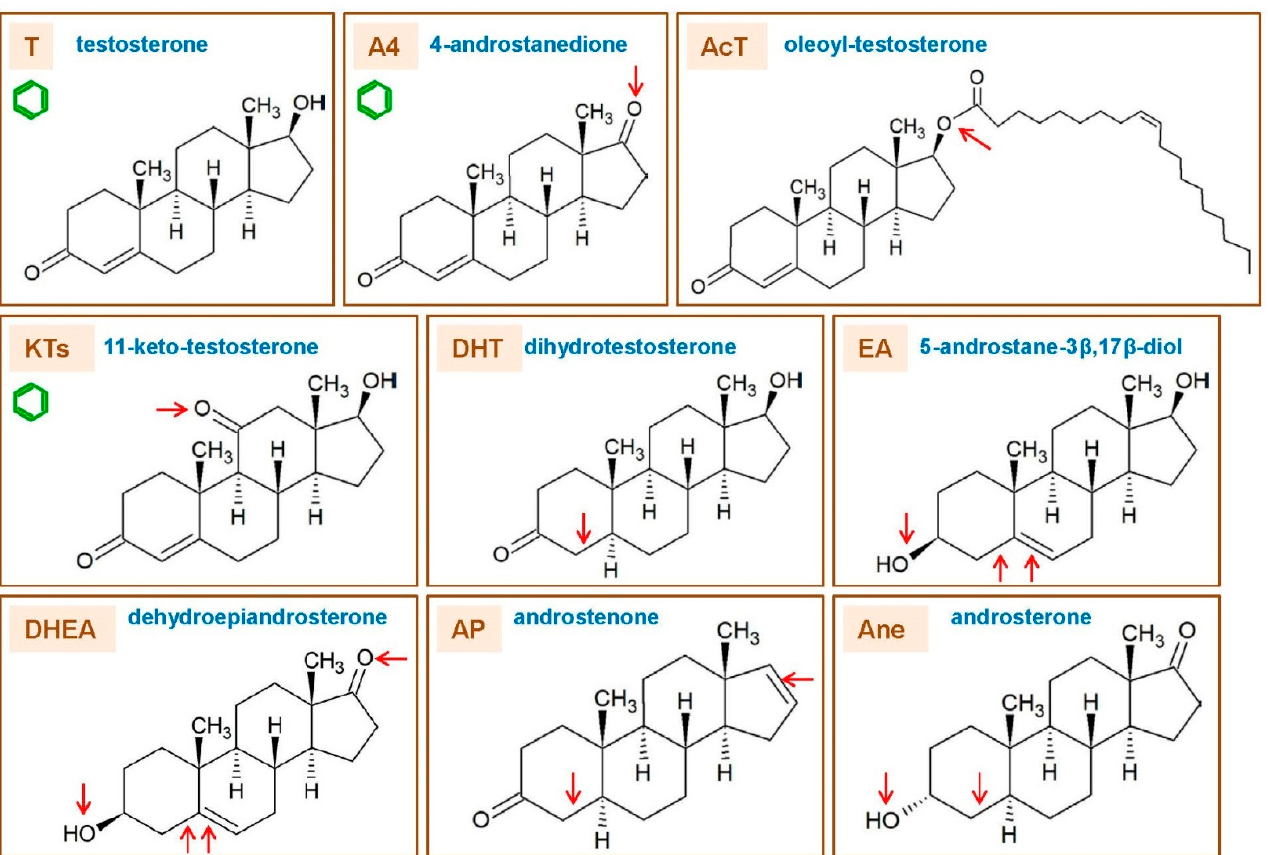
Figure 2. Types of human androgens. The androgen molecular species (or groups of them) show similar chemical structures, are synthesized in a number of different tissues (but mainly in adrenal glands and the gonads) and elicit physiological effects that are largely complementary. DHEA: dehydroepiandrosterone; T: testosterone; AcT: 17 β -acyl-T, a group of esters; KTs: 11-keto-androgens (essentially derived from T, DHT and A4; the 11-keto forms are more active than the 11-hydroxyl ones); DHT: dihydrotestosterone; A4: 4-androstenedione; AP: androgenic pheromones; EA: estro- genic androgens (i.e., they bind to the ER and AR); Ane: androsterone—a catabolite of T—which is an agonist of the farnesoid receptor, acting in the regulation of bile acid signaling. There are many other androgen catabolism products and intermediate molecular species of the androgen metabo- lism, which specialized functions have not been described in depth, but have been studied as phar- macological subjects, metabolic markers or substrates for synthetic hormone production. The an- drogens susceptible of aromatization are marked with green benzene icons. Small red arrows point to the distinguishing structural features of the different groups of androgens in comparison with T taken as the standard and best-known androgen.